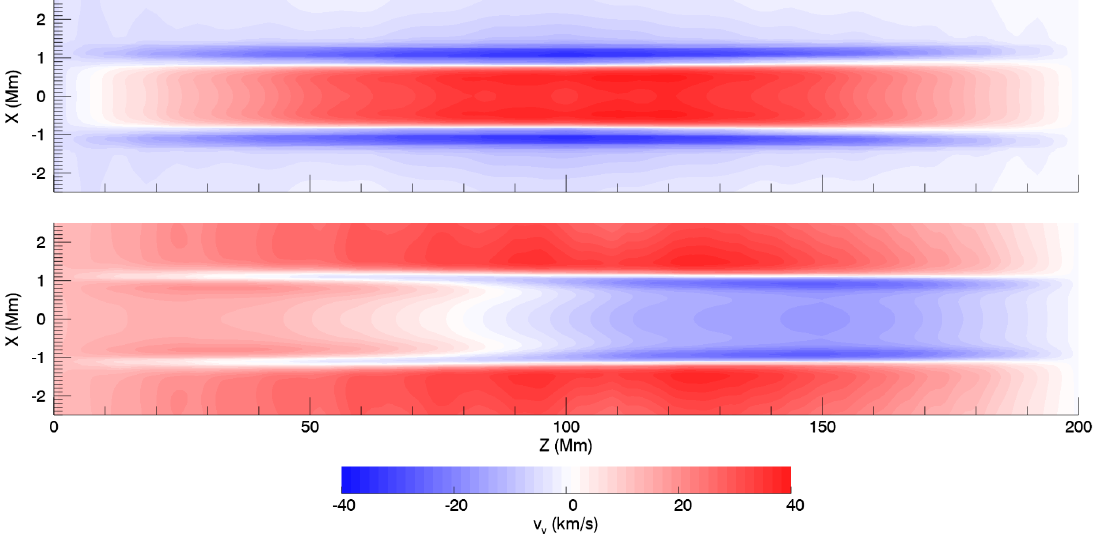
Figure 4. Vertical cuts of the driven component of the velocity ( v y ) for the ResUni ( upper ) and BbUni ( lower ) simulations prior to the formation of the KHI. The cuts show v y in the x = 0 Mm at t = 300 s. See text for